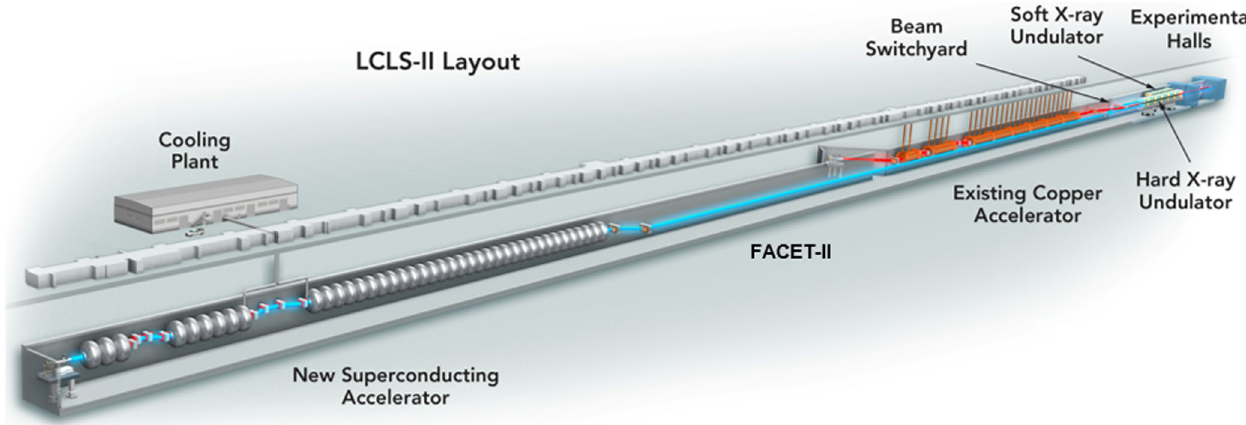
FIG. 1. Layout of the LCLS-II project, showing the new superconducting linac at left. Its beam passes over FACET-II and the original LCLS, both normal-conducting copper linacs. Bunches from either LCLS source can be kicked into either of the two new undulators, for hard and soft x